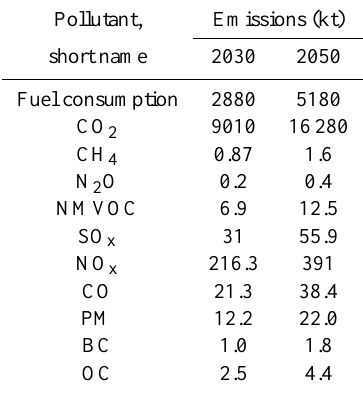
Table 5. Fuel consumption and emissions in gigagrams (kilotonnes) of various pollutants as a result of transpolar shipping and oil and gas-related shipping in the Arctic in 2030 and